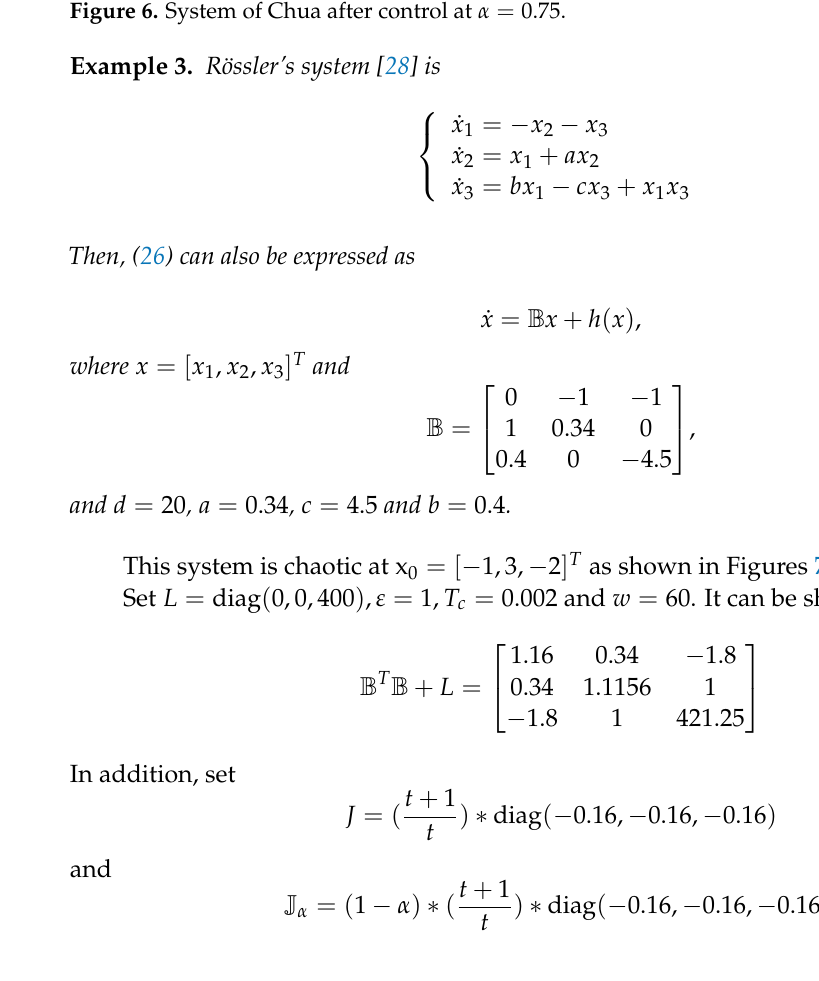
Figure 6. System of Chua after control at α =